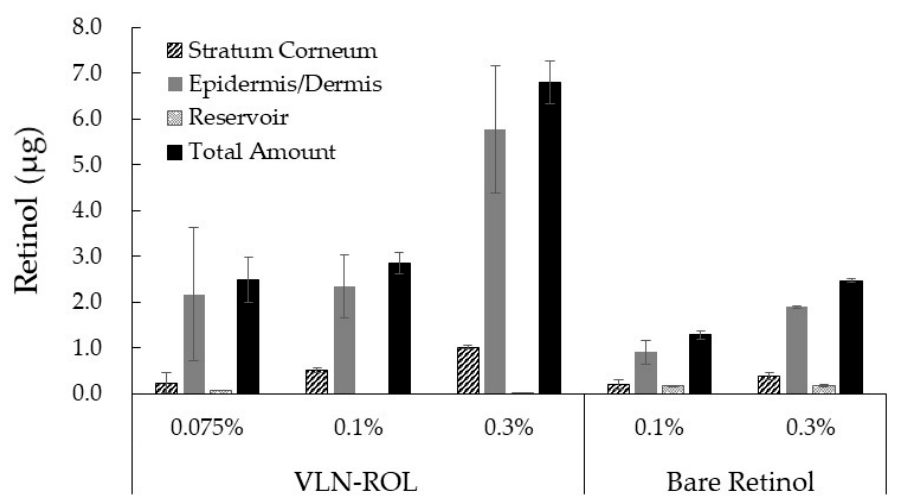
Figure 3. Distribution of retinol permeated in the stratum corneum, epidermis/dermis, and receptor medium, 16 h after the application of o/w cream which contained VCN-ROL and bare retinol at different concentrations of retinol.